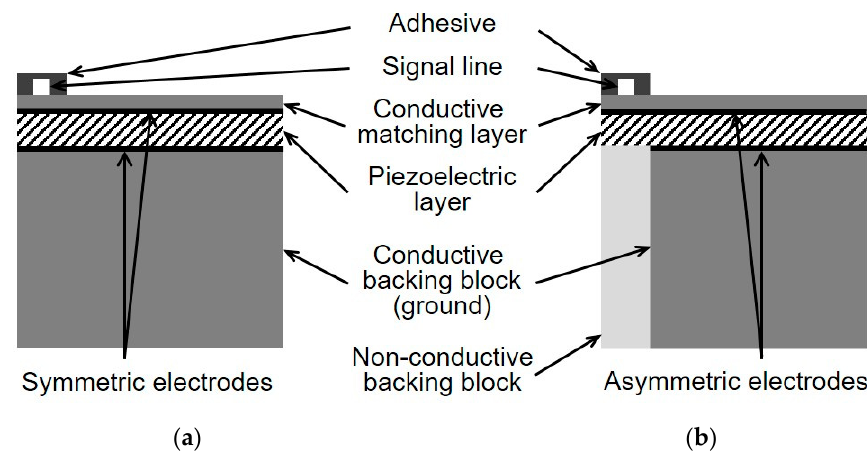
Figure 1. Schematic diagrams of ( a ) conventional transducer; and ( b ) proposed transducer.